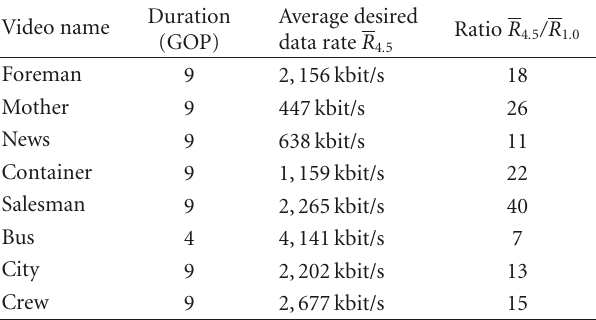
Table 4: Transmitted video